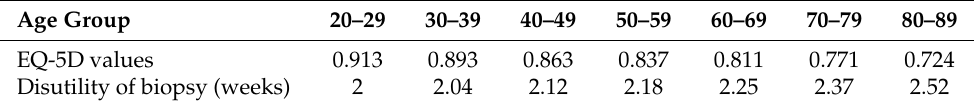
Table A2. Age dependent disutility of biopsy.